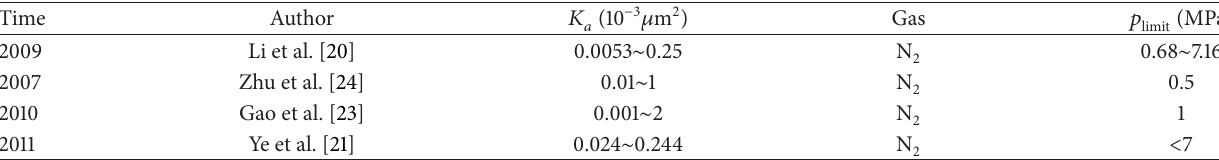
Table 5: Experimental results of limit